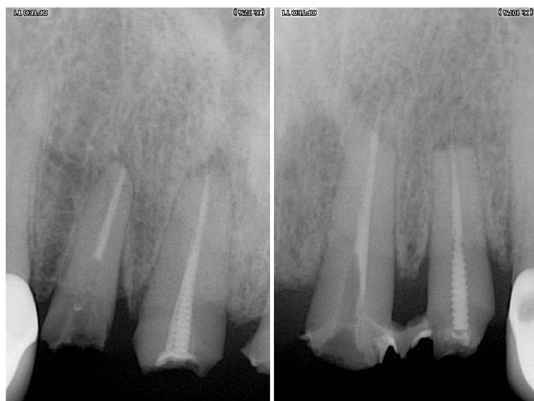
Figure 4: Intraoperative image of the implants placed, not being in contact with the buccal surface of the roots.